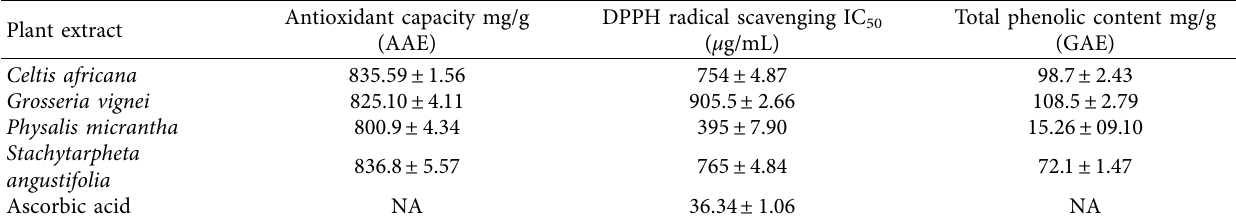
NA—not applicable.